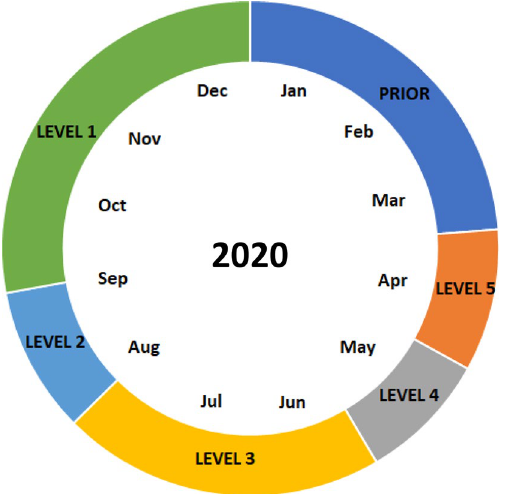
Figure 1. Occurrence and duration of the South African COVID-19 lockdown levels in 2020. January to March: pre-COVID-19 lockdowns (dark blue). Humans were not allowed on beaches in lockdown levels 5 to 3, but access was granted during levels 2 and